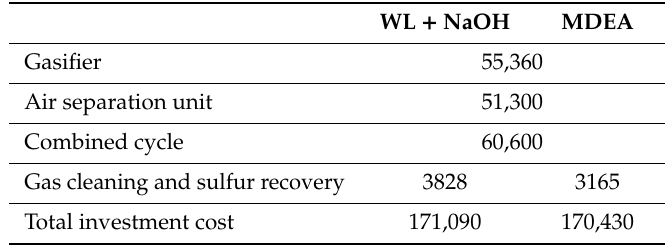
Table 14. Installed capital costs (in thousands USD 2019 ) for the whole